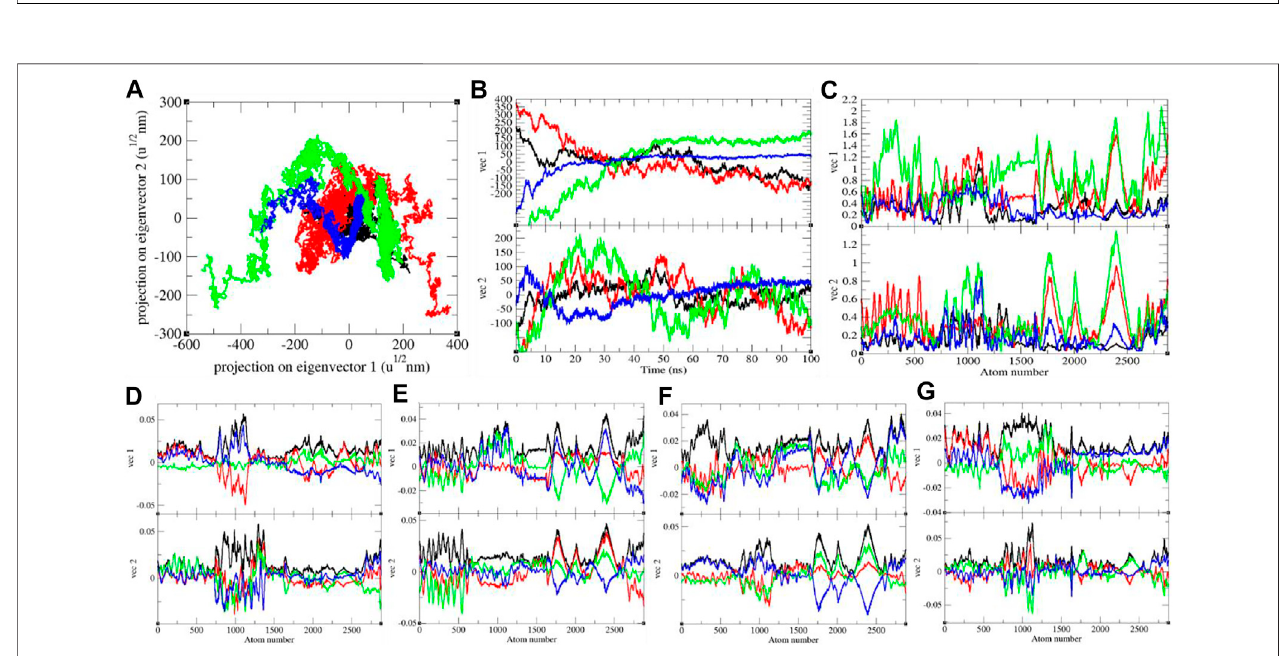
FIGURE 6 | (A) The 2D projection and (B) projections of trajectories of SARS-CoV-2 spike protein. (C) Eigen RMSF. The color codes have the same meaning as described in Figure 2 . The Eigen components were calculated for SARS-CoV-2 spike protein at (D) 0 ° C, (E) 20 ° C, (F) 40 ° C, and (G) 60 ° C, respectively.